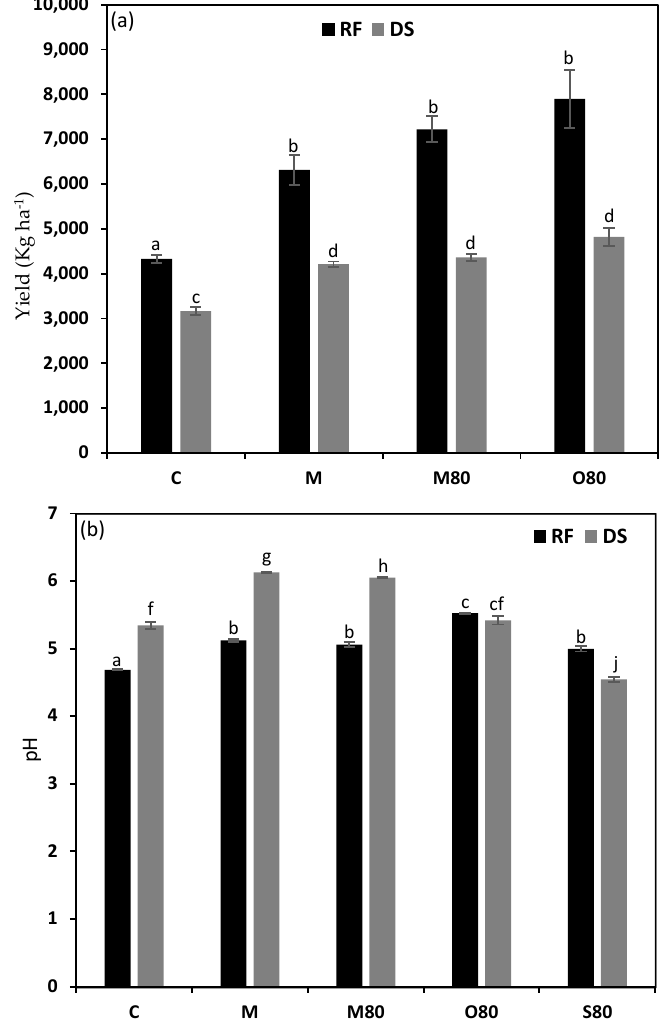
Figure 2. Treatment e ff ect on ( a ) Yield and ( b ) soil pH of the Rainforest, RF, and Dry Savanna, DS, soils. C = control, M = manure treatment, M80 = Manure + 80 kg N / ha, O80 = No manure + 80 kg N / ha S80 = soil pot microdosed with 80 kg N / ha without any vegetables. Bars with di ff erent letter(s) for each site are significantly di ff erent at p < 0.05. (n = 3).